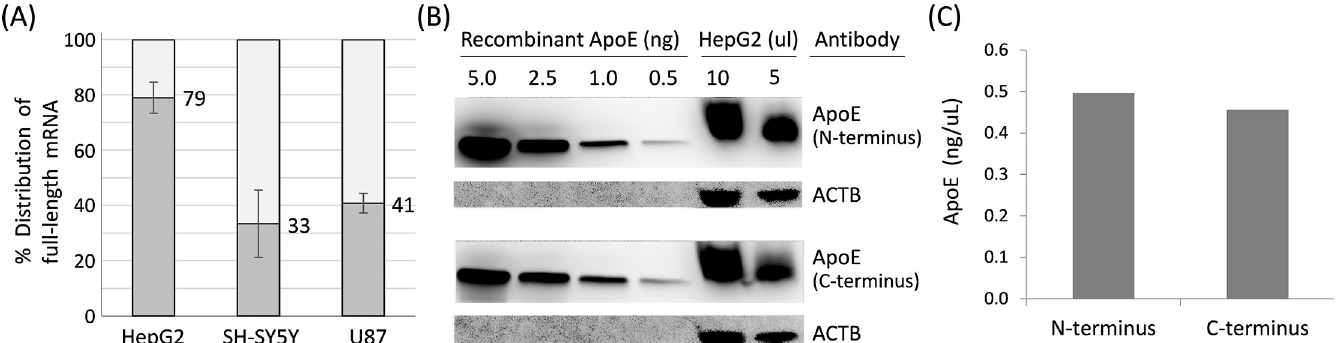
Fig 2. qRT-PCR of the APOE full-length mRNA and Western blot of ApoE protein. (A) Compositions of full-length mRNA are 79%, 33%, and 41% of total RNA in HepG2, SH-SY5Y, and U87 cells, respectively. (B) Western blots of recombinant ApoE protein and HepG2 cell culture lysates, blotted with antibodies against the N- terminus (upper panel) and C-terminus (lower panel) of ApoE or with ACTB. (C) Semiquantitative analysis on blots of 5 μ l HepG2 cell culture lysates using both N- and C-terminus antibodies. ACTB: β Actin; qRT-PCR: quantitative reverse transcriptase polymerase chain reaction.